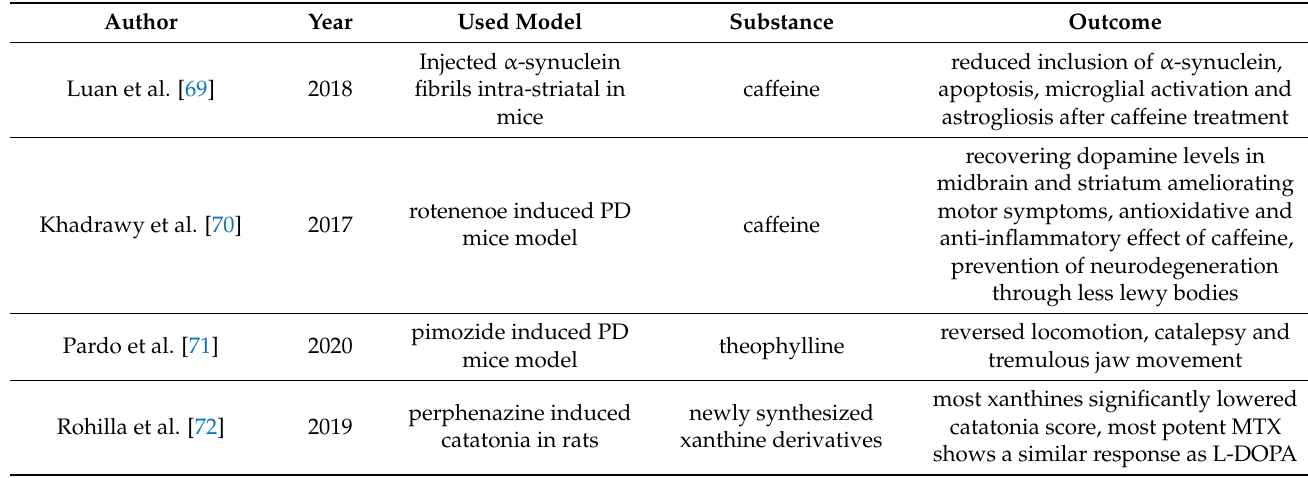
Table 4. Summary of recent animal and cell culture studies investigating the relationship between methylxanthines and Parkinson ´ s disease (PD).